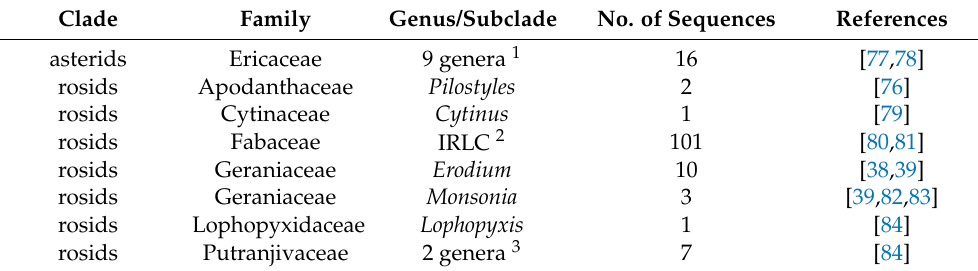
Table 9. Complete chloroplast sequences included in the inverted repeat-lacking (IRL) dataset.